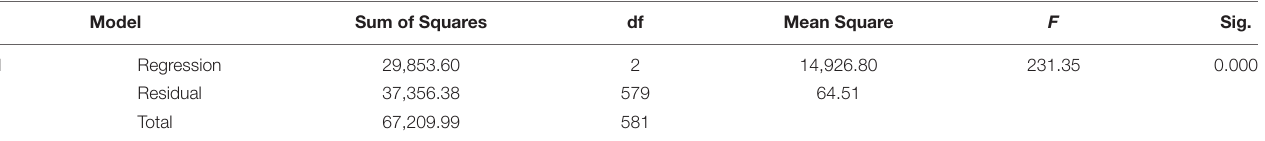
TABLE 6 | ANOVA for teachers’ immunity, mindfulness, and engagement. Model